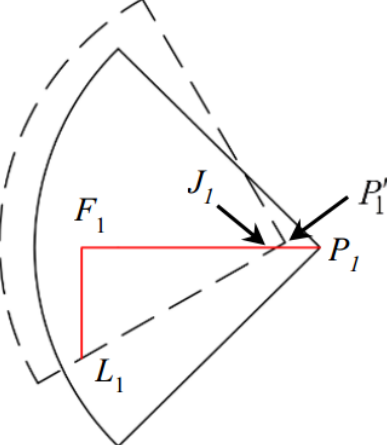
Figure 15. Remaining kinematic margin of leg 1 and eighth of stride length varying with twisting angle θ and the lateral distance r